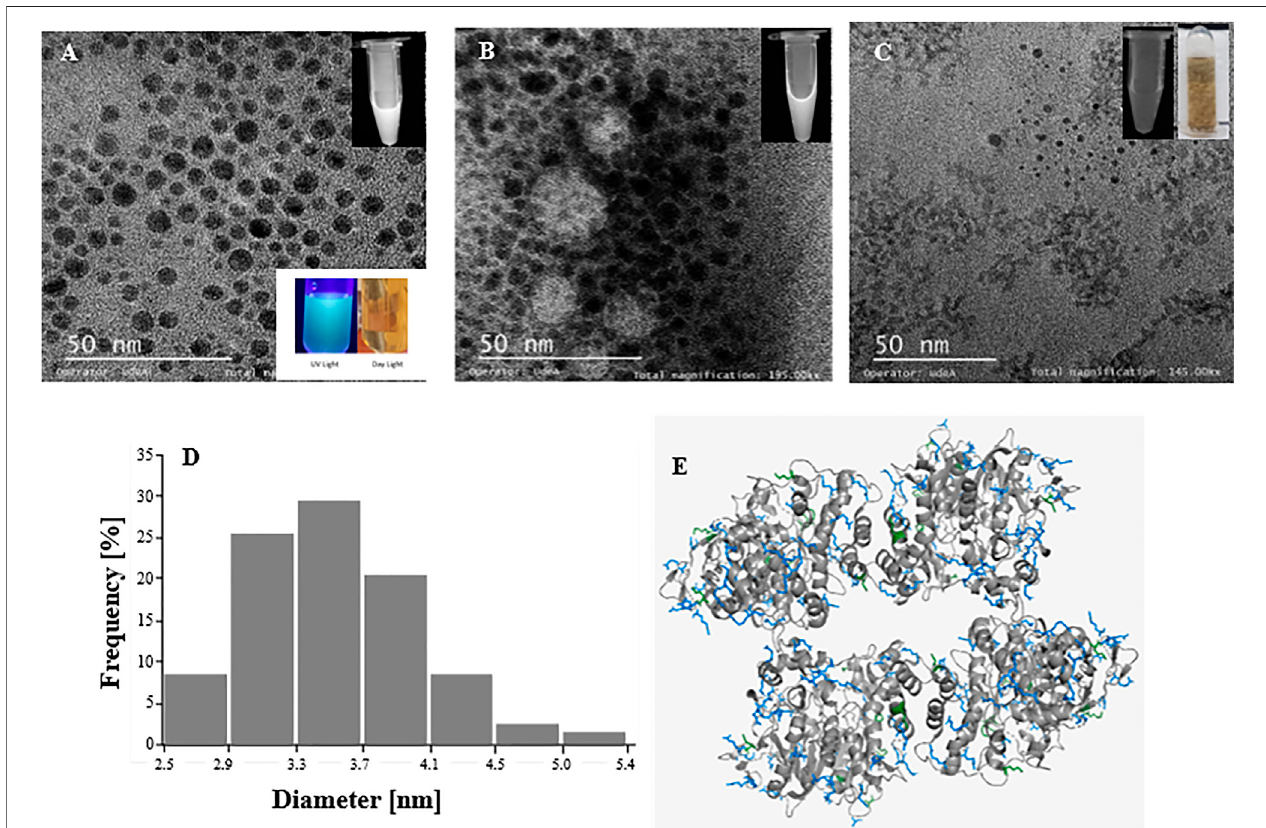
FIGURE 3 | High-resolution transmission electronical microscopyHR-TEM) images for (A) CD, (B) CD conjugated with AChE at 5 U mL − 1 and (C) CD – AChE conjugate and graphene oxide (GO) at 100 ppm. (D) CD histogram and (E) ribbon model of the AChE enzyme structure (PDB ID 1C2O) and representation of amino acids lysine (green) and arginine (blue). The insets in (A – C) show the changes in the fl uorescence intensity under UV light. The inset in (C) also shows the aggregation of the conjugate in the presence of GO at 100 ppm as the main mechanism for CD fl uorescence quenching.